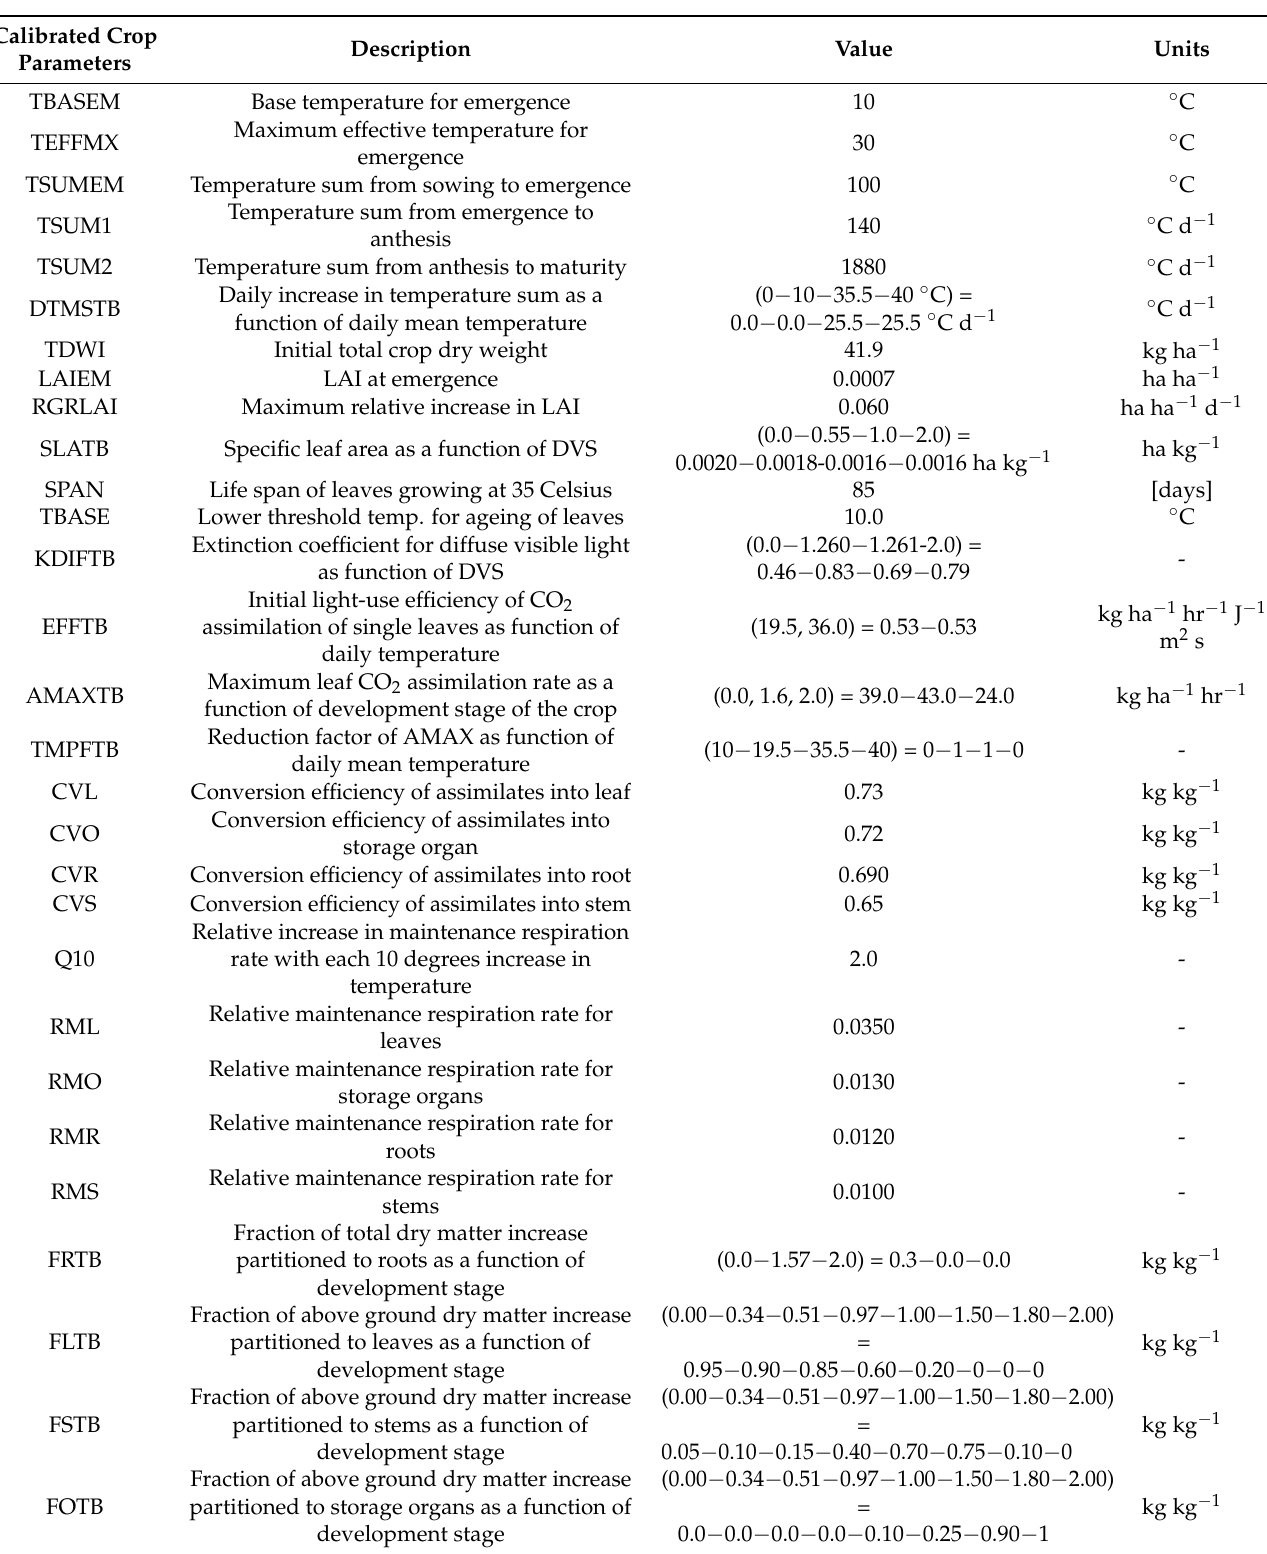
Table A2. Main crop parameters used in WOFOST model for pear tree growth